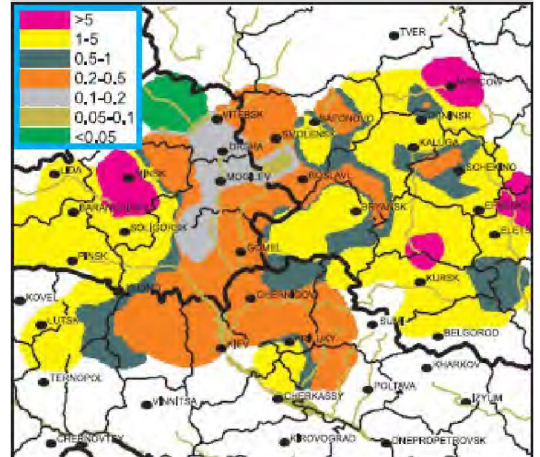
Figure 14. Precipitation distribution in Chernobyl on April 29,